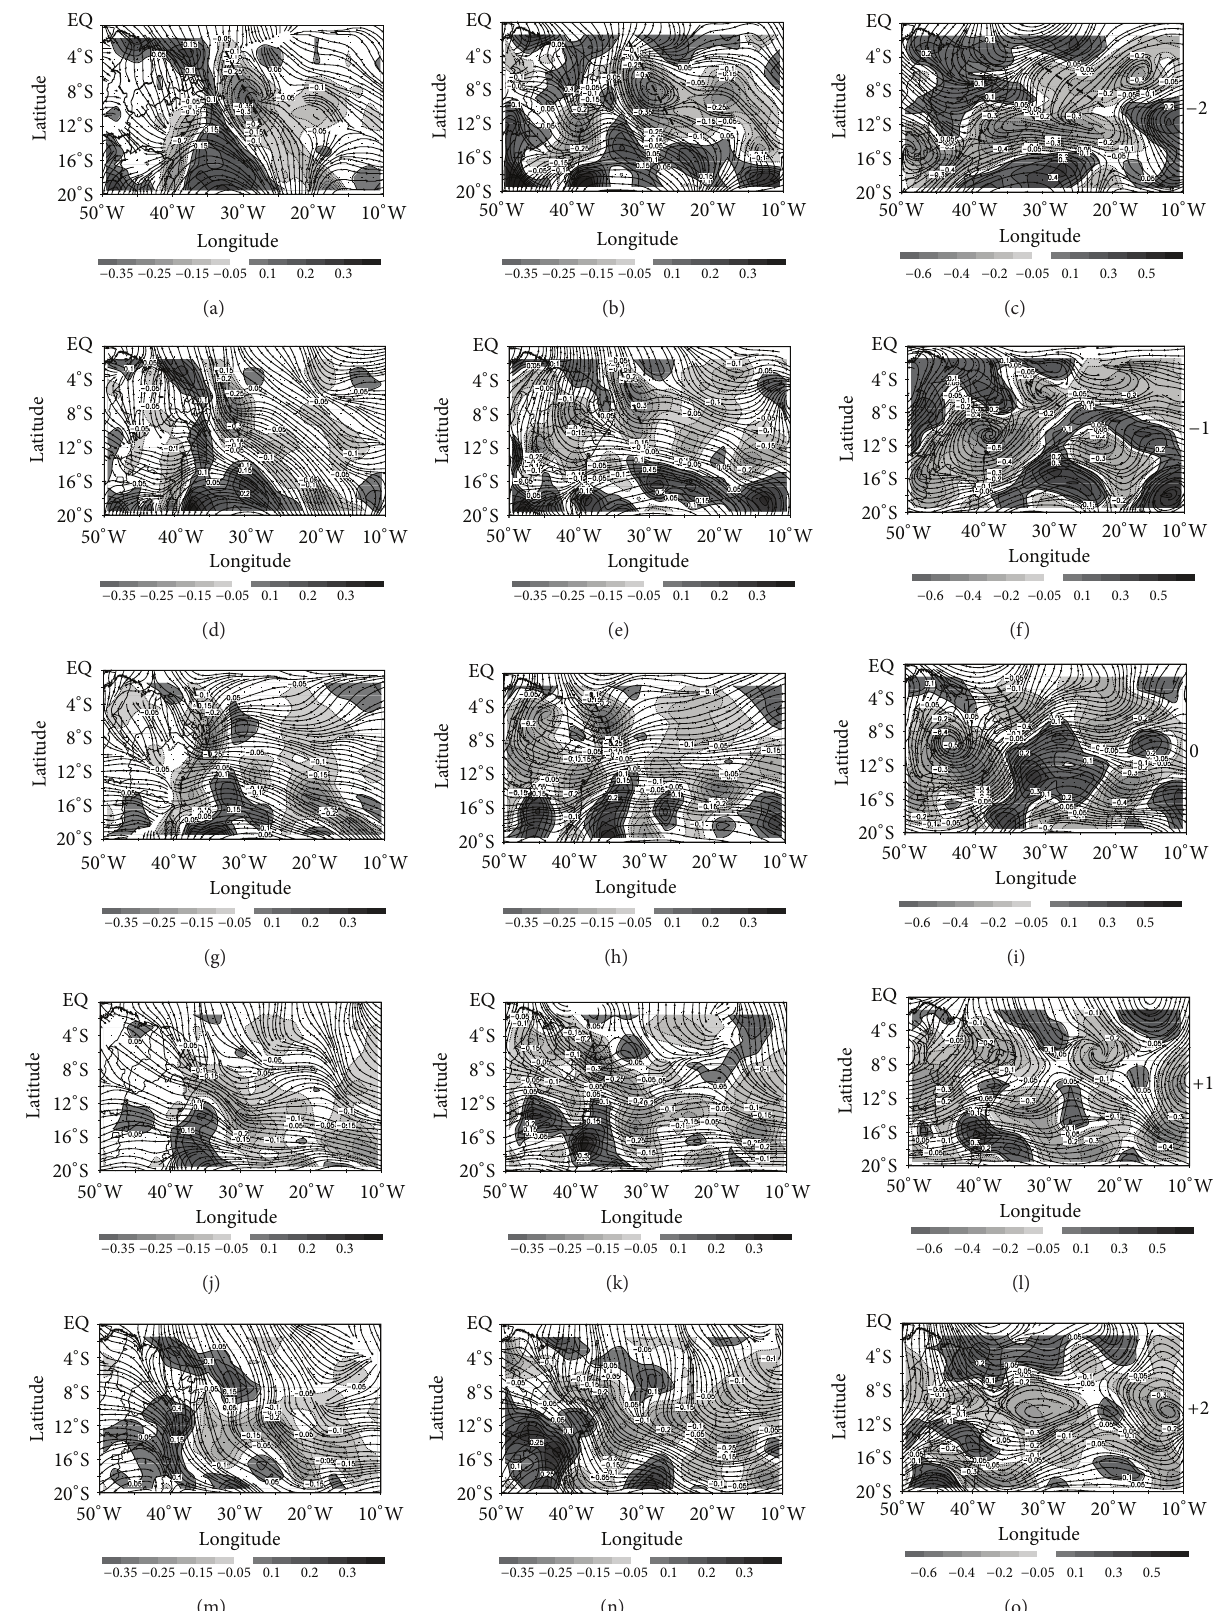
Figure 2: Relative vorticity (shaded, 10 −5 s −1 ) and streamlines composite anomalies in the period from April to July 2006 at 1000hPa (left column), 850 hPa (center column), and 700 hPa (right column). The approximate trough axis is shown by dashed